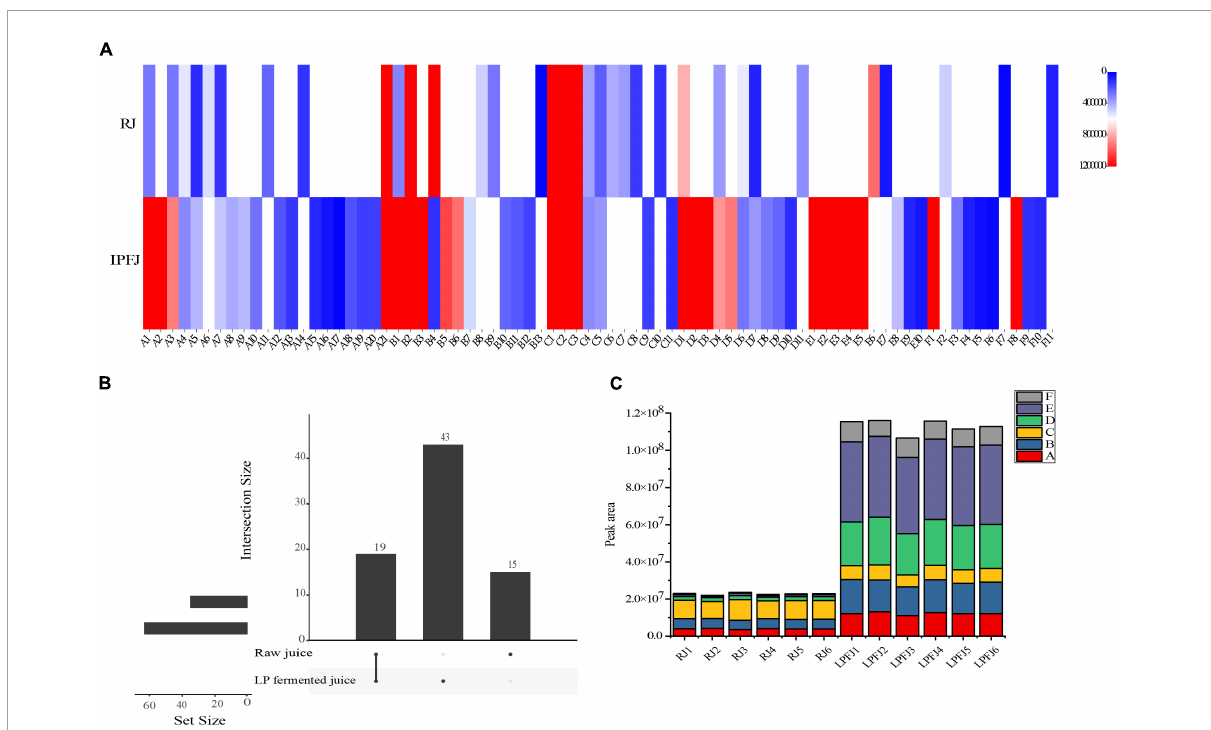
FIGURE2 Change in aroma profiles of RJ and Lactobacillus plantarum fermented juice (LPFJ). (A) Content of aroma substances: the degree of redness and blueness indicate the higher and lower content, respectively. (B) Quantity of aroma substances: the value represents the type and a larger value indicates the sample richness of that substance. (C) A stacked histogram of volatile contents: A-alcohol; B-aldehyde; C-ester; D-acid; E-ketone; and F-others. RJ, raw juice; LPFJ, L. plantarum fermented juice.